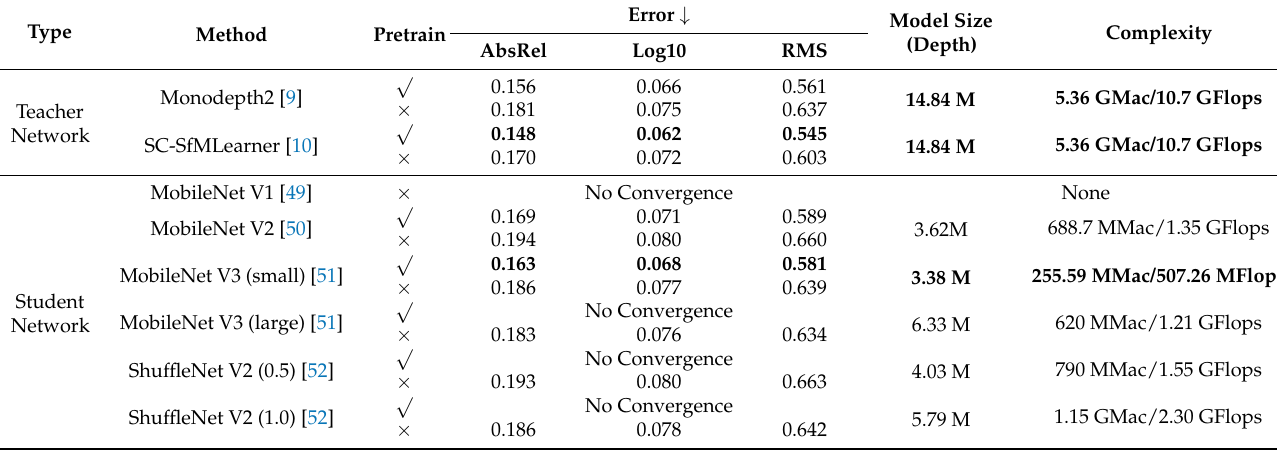
Table 1. Selection of teacher and student